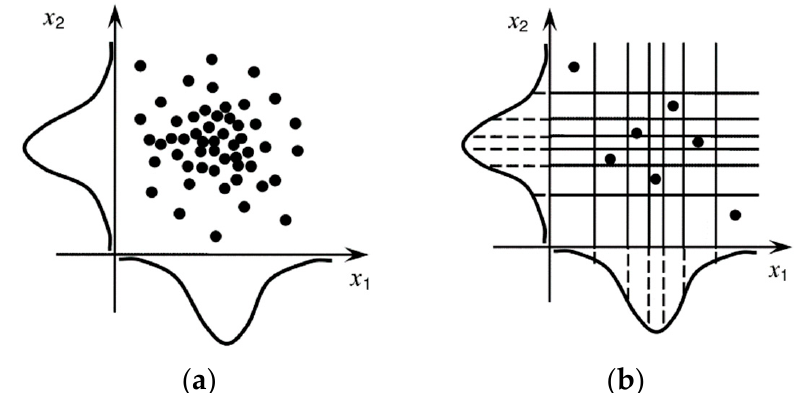
Figure 6. Comparison of sampling methods of Monte Carlo analysis. ( a ) Simple random sampling; ( b ) Descriptive sampling.